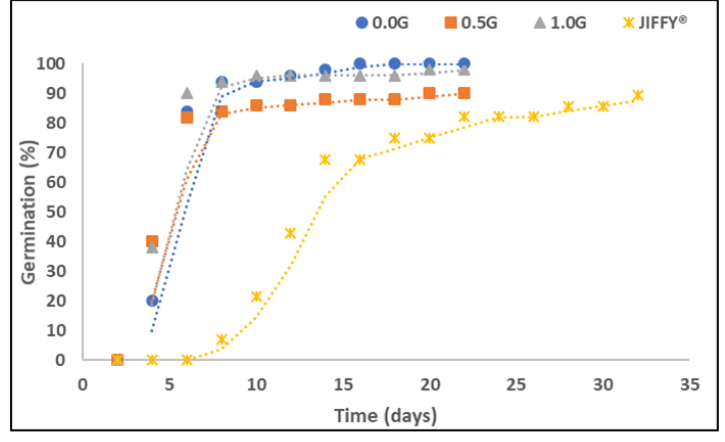
Figure 1. Germination curves of in vivo (Jiffy ® ) and in vitro (agarized Highly Fertile medium) sown Moringa seeds; different curves represent the germination behaviour of samples grown adding increasing concentrations of gibberellic acid (GA3): 0 (0.0 G), 0.5 (0.5 G) and 1 (1.0 G) mg/L, and material cultivated in Jiffy ® .